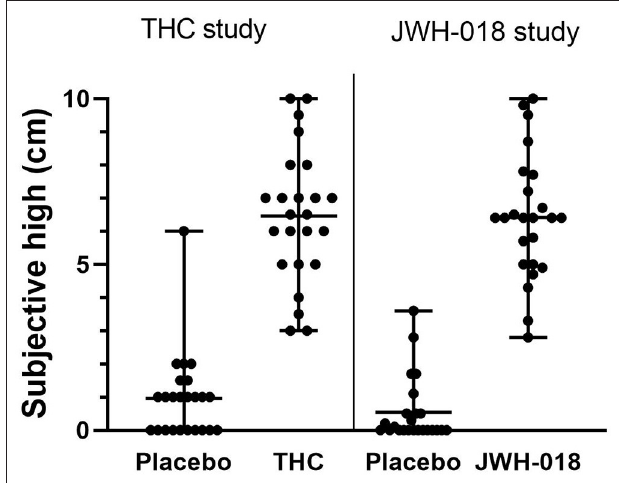
FIGURE 2 | Scatter plot with mean and range of subjective high scores in placebo and drug conditions in both samples.